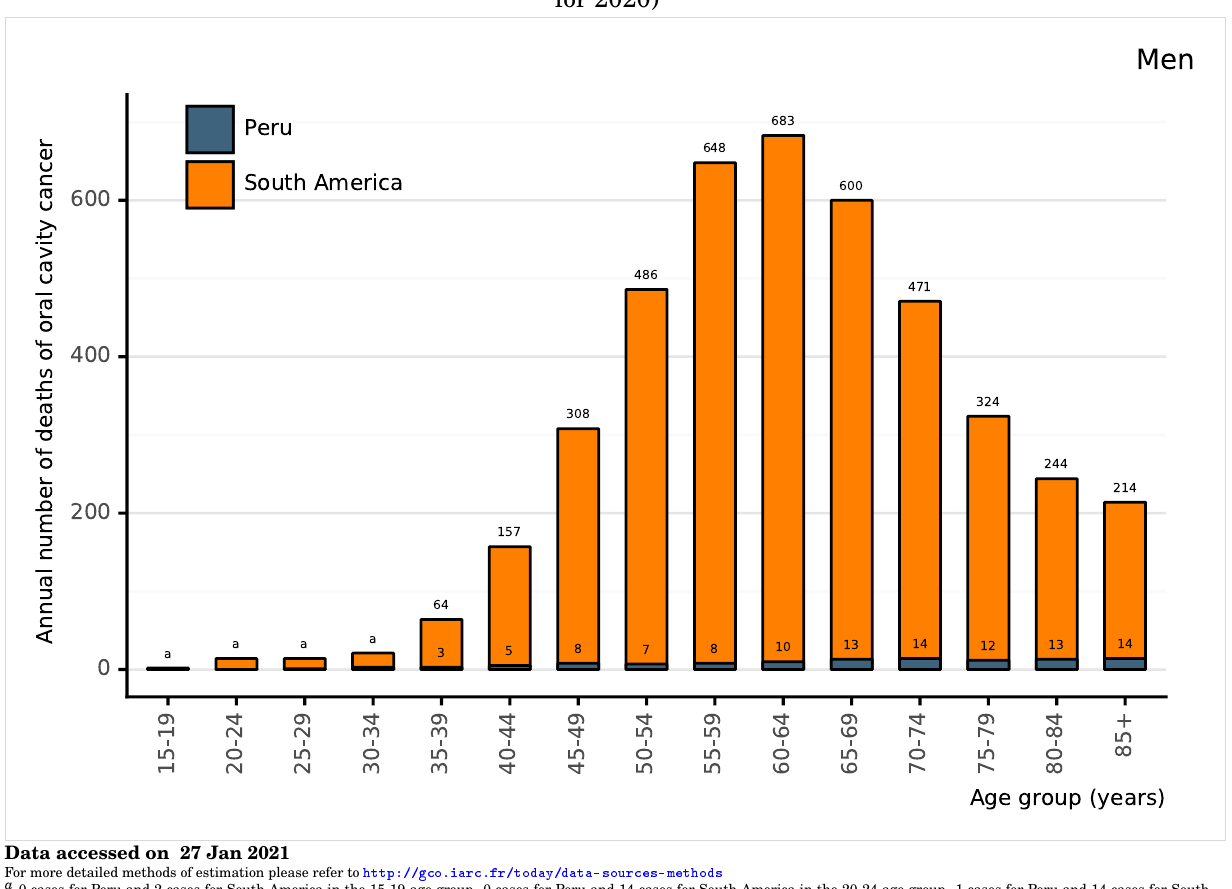
Figure 128: Annual number of deaths of oral cavity cancer among men by age group in Peru